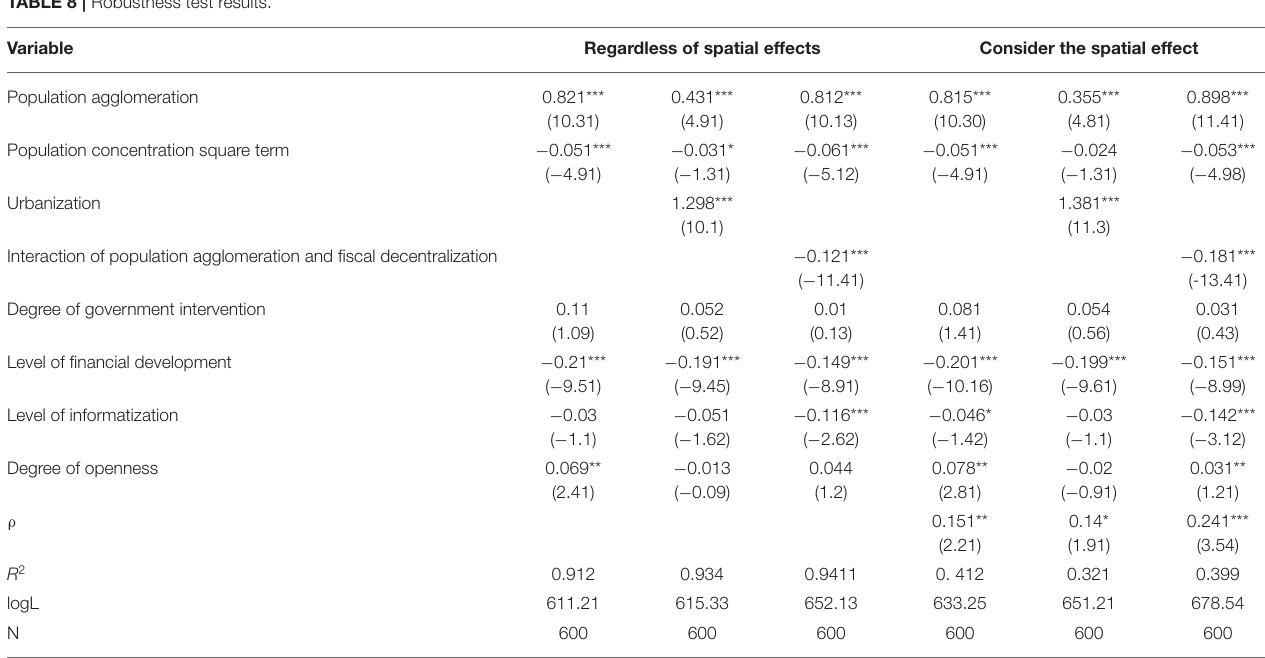
TABLE 8 | Robustness test